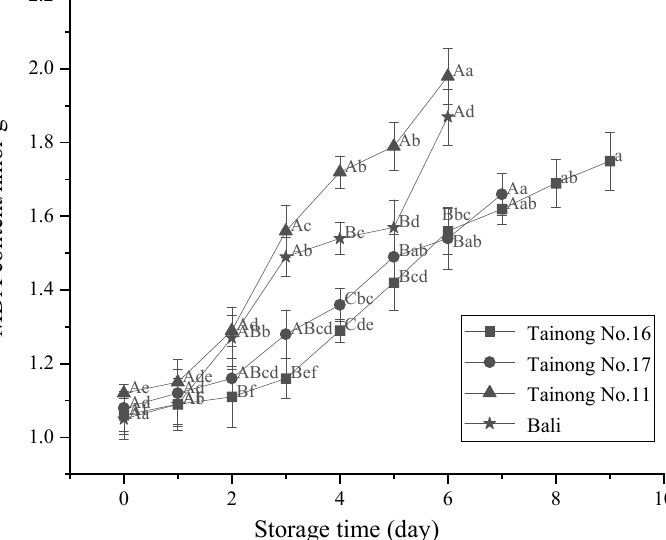
Figure 5. Changes in MDA content in freshly cut pineapple during storage. Different capital letters (A–C) indicate significant ( p < 0.05) differences in hardness between varieties at the same storage time; different lowercase letters (a–f) indicate significant ( p < 0.05) differences in hardness between the same varieties at different storage times.